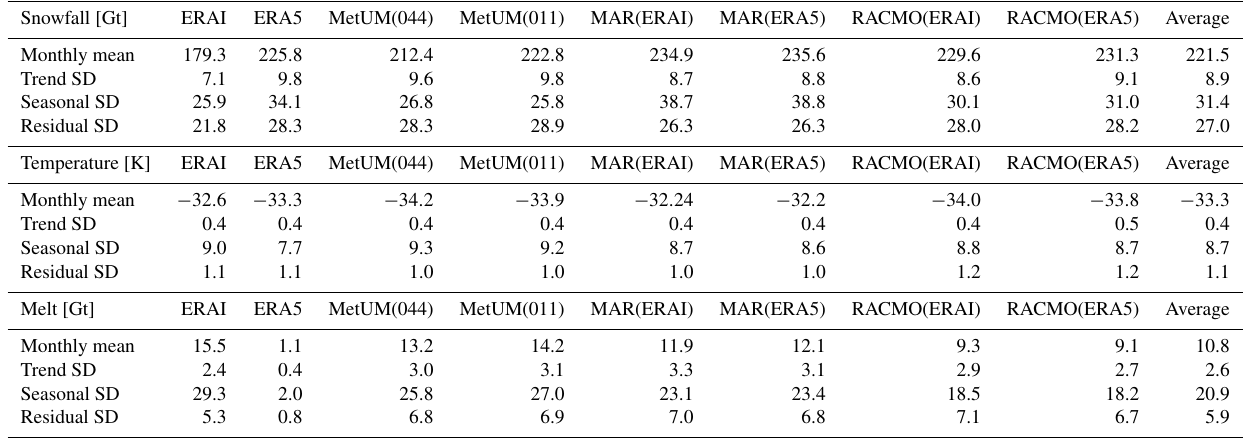
Table 2. After aggregating across the ice sheet, the mean and standard deviation for each component of the monthly time series for total snowfall, average near-surface air temperature and total melt are given. Values for snowfall and melt are expressed in units of gigatonnes, while values for temperature are expressed in